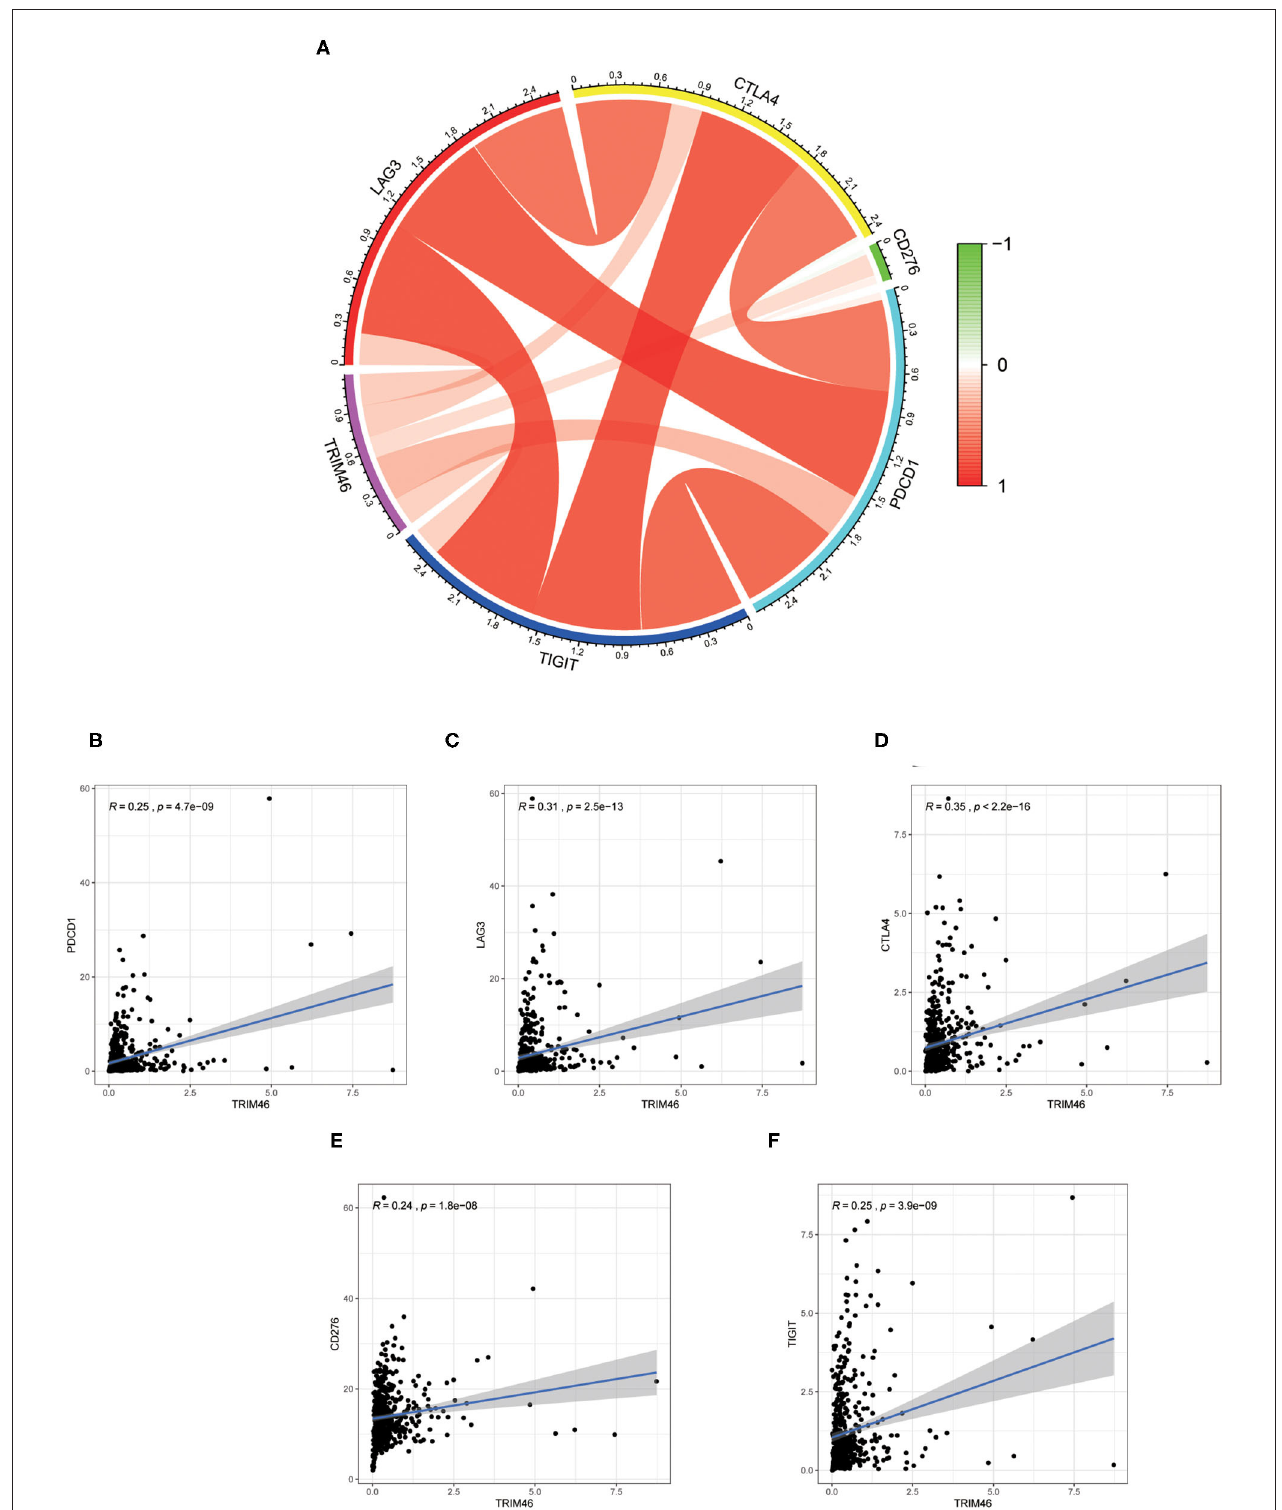
FIGURE 10 | Correlation of the levels of immunosuppressive molecules with TRIM46 expressions. (A) Circle diagram of associations between the levels of immunosuppressive molecules and TRIM46 expressions; (B–F) TRIM46 was related to TIGIT, CD276, CTLA4, LAG3, and PD-1 according to correlation assays.